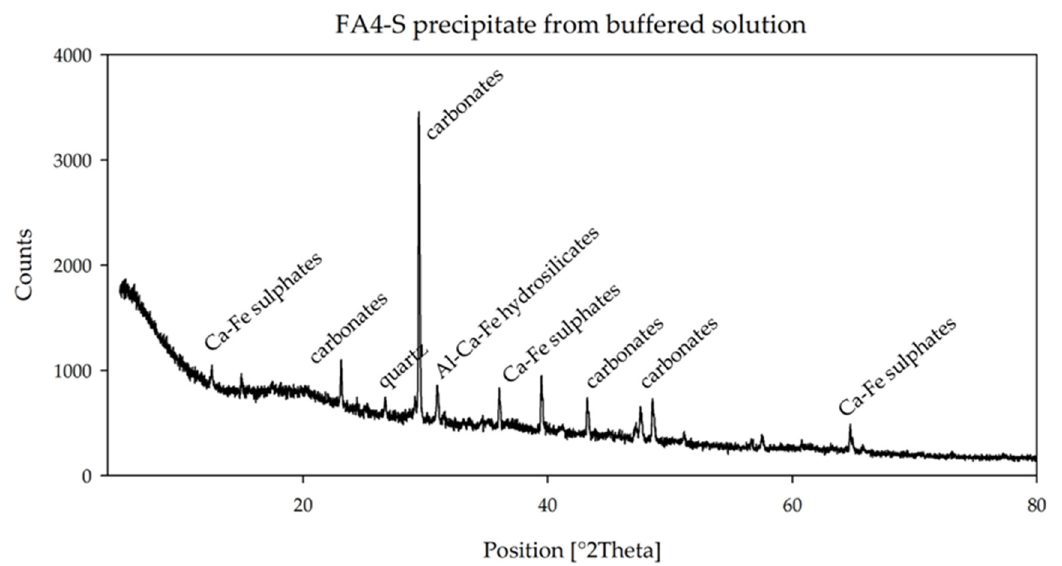
Figure 4. XRPD pattern of FA3-L precipitates and qualitative analyses for content of mineral phases.